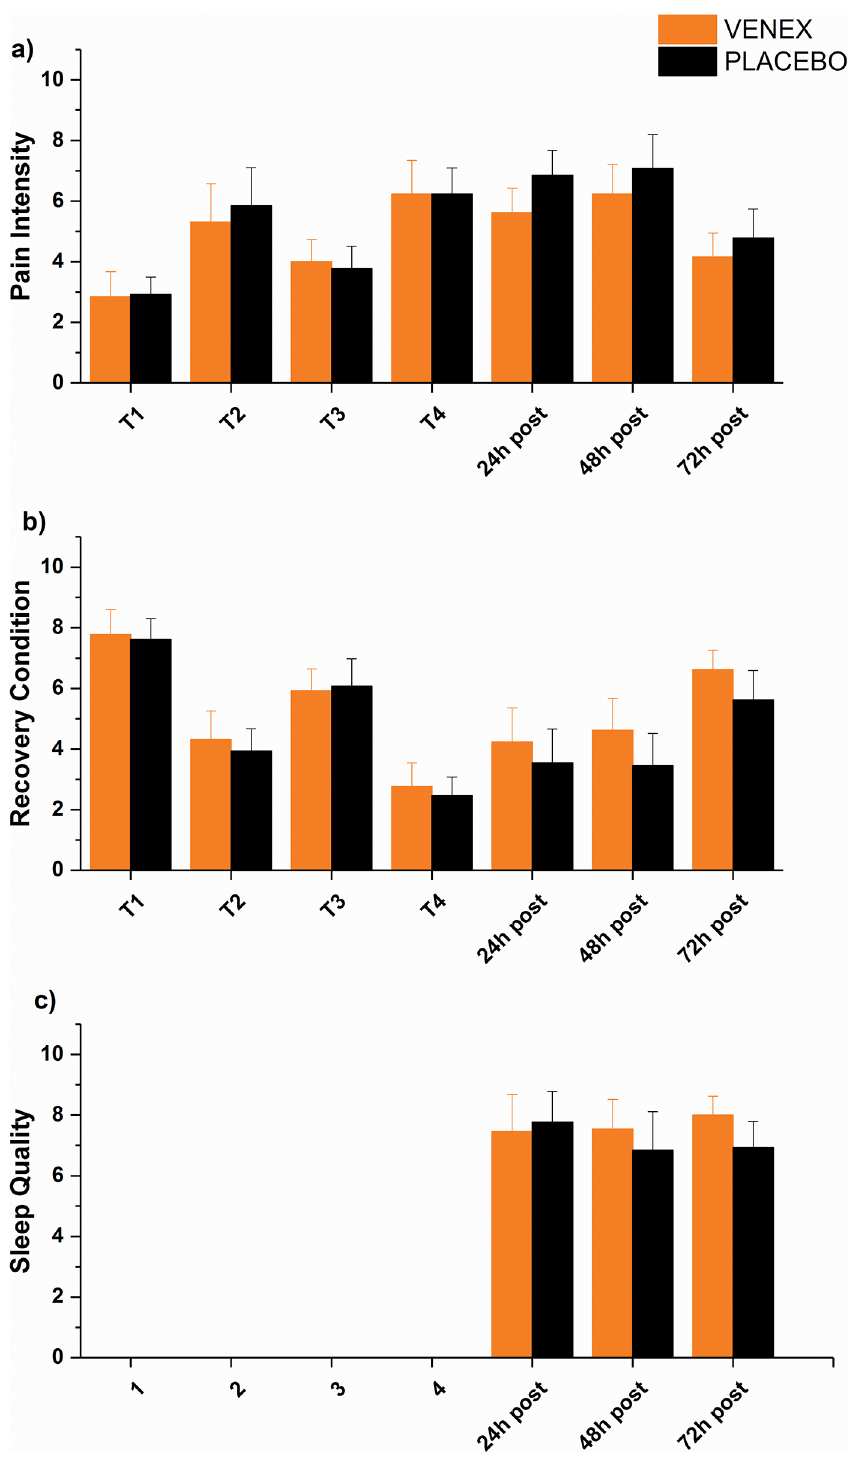
Fig 4. Mean ± 95% confidence interval of a) pain intensity (PI), b) recoverycondition (RC) and c) sleep quality (SQ). There were no differences betweentreatments but a strong Cohen’s d of 0.8 for PI (a) 24h post and a medium Cohen’s d for RC (b) 24h post (0.6) and 48h post (0.7). Sleep quality(c) indicateda trend to significancewith p = 0.068 duringthe third night and also a high Cohen’s d of 0.8 at this measurement.